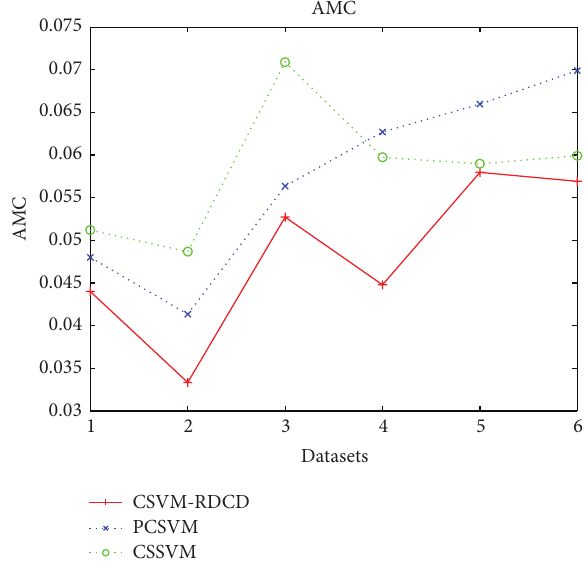
Figure 1: Average misclassification cost comparison of three algo- rithms using CSVM on 6 datasets.